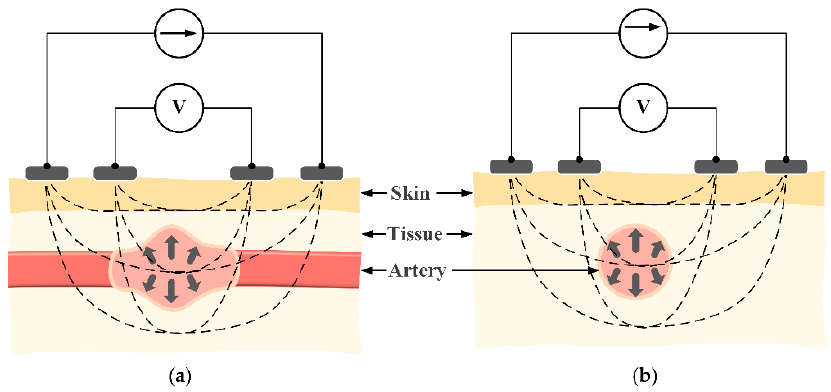
Figure 2. Principle of bioimpedance (BI) measurement with alternating current flowing through external electrodes in ( a ) a vertical structure and ( b ) a horizontal structure.